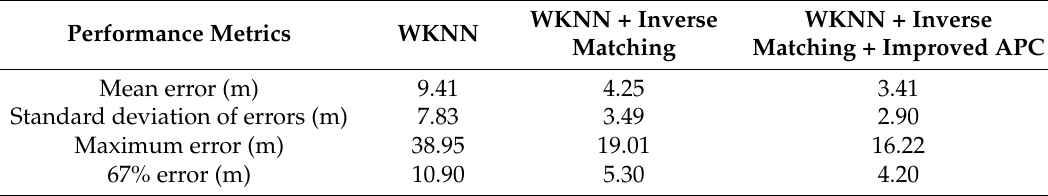
Figure 21. CDFs of errors by using different Wi-Fi localization approaches. Table 2. Statistical errors by using different Wi-Fi localization